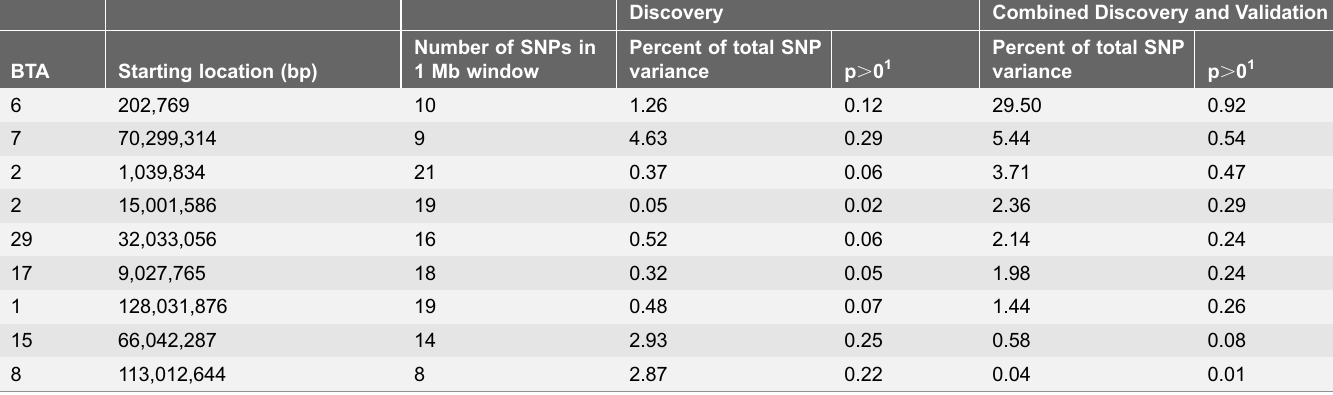
Table 2. Most significant 1 Mb windows from Bayes C analysis of discovery and combined discovery and validation data.